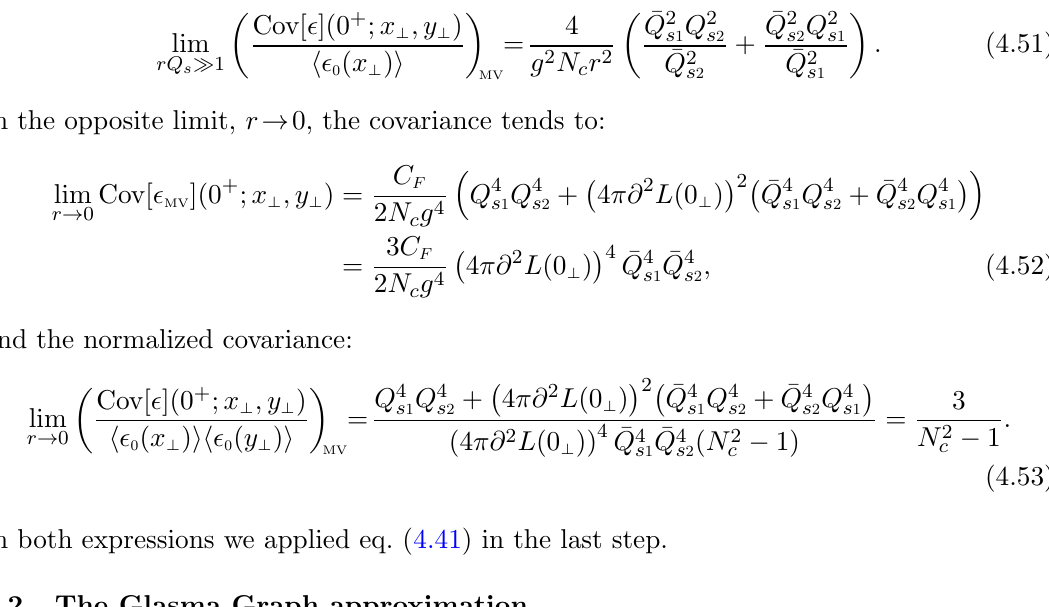
Figure 3 . LEFT: sum of the (cid:12)rst two orders of the N against rQ s for Q s = Q s and N c = 3. Blue full curve: N 0 1 2 N 0 - and N (cid:0) 2 -order terms. RIGHT: ratio between the complete result and the sum of the (cid:12)rst two c c orders of the N c